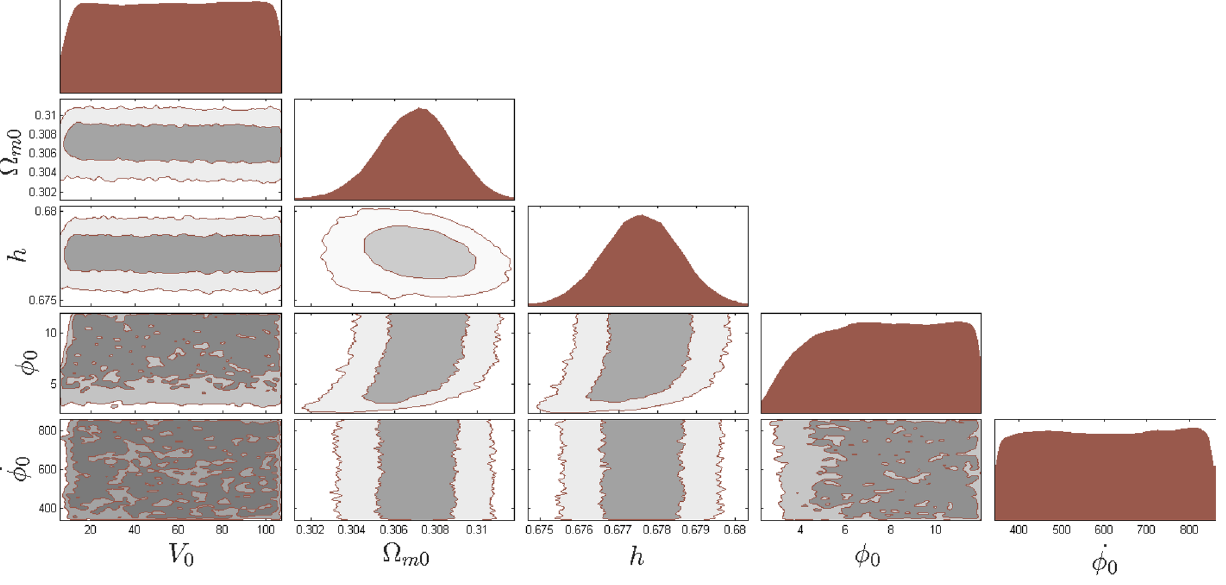
Fig. 4 The 2 σ confidence level contour plots for various pairs of the free parameters ( V 0 , Ω m0 , h , φ 0 , ˙ φ 0 ) for which the φ CDM model with the Zlatev–ang–teinhardt potential V (φ) = V 0 ( exp ( M pl /φ) − 1 ) is in the best fit with the Λ CDM